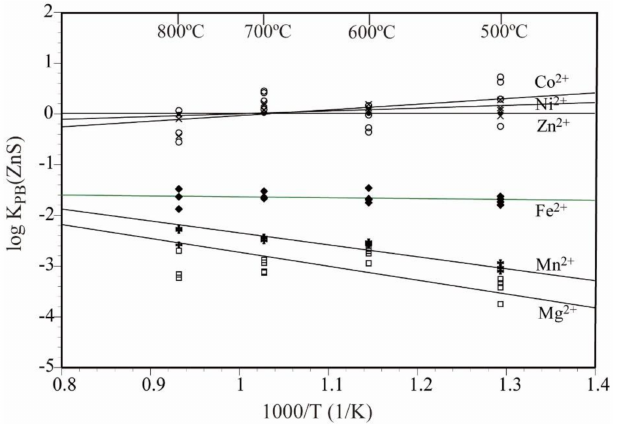
Figure 3. Temperature dependence of logarithmic value of bulk partition coefficient (log K PB (ZnS)) in ZnS–(Ni, Mg, Co, Fe, Mn)Cl 2 –H 2 O system. The temperature dependence lines were obtained using the least-squares